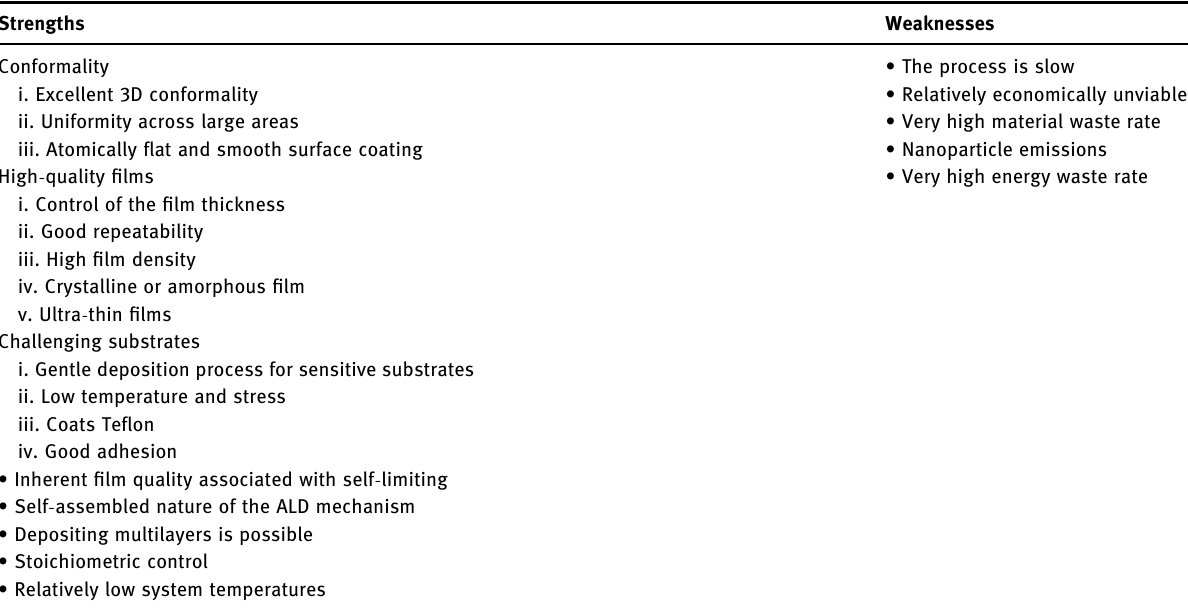
Table 3: Strengths and weaknesses of atomic layer deposition [ 2 ]